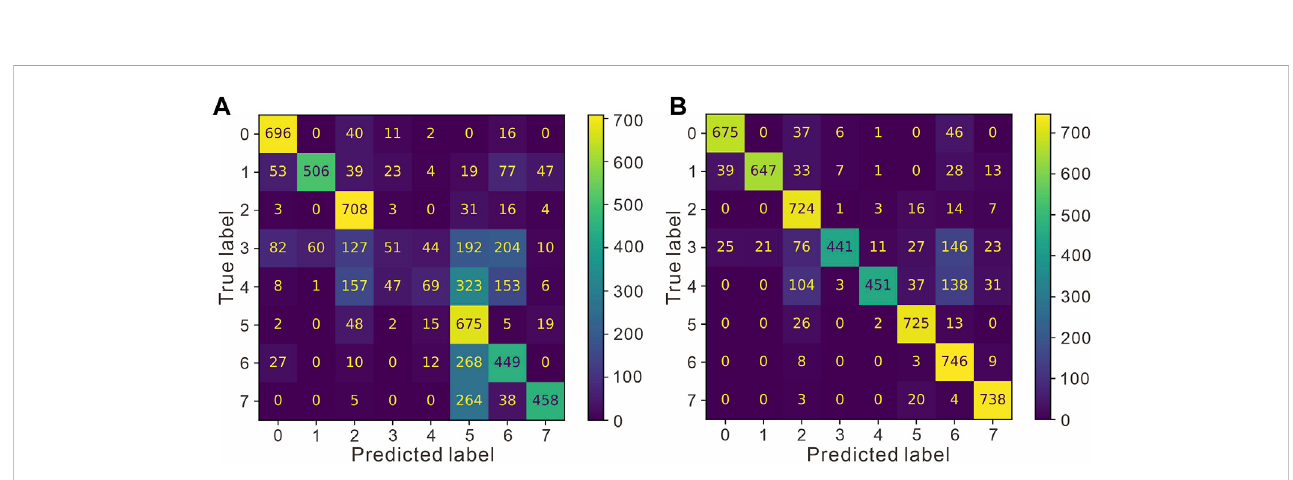
FIGURE 11 Comparison of the confusion (error) matrix before and after improvement. (A) The confusion (error) matrix of the Naive Bayes. (B) The confusion (error) matrix of the improved